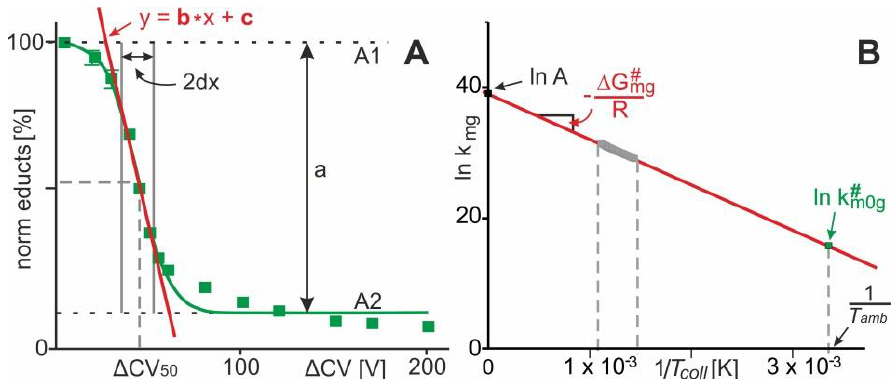
Figure 3. ( A ) Course of normalized ion intensities of complex ions ( 𝒏𝒐𝒓𝒎 (𝒆𝒅𝒖𝒄𝒕𝒔) ) as a function of collision cell voltage differences ( 𝚫𝐂𝐕 ). Each data point is the mean of several independent measurements. Vertical bars give standard deviations. The curve was fitted using a Boltzmann function. The tangent line equation is taken from the Boltzmann fit. “ a ” describes the difference between the lowest and highest data points on the sigmoidal fit. “ 2dx ” is the x-axis interval within which the steepest decline of educts is observed; the center of the 2dx interval is 𝚫𝐂𝐕 50 . ( B ) Arrhenius plot for the course of protein-ligand complex dissociation in the gas phase. The value for 𝐥𝐧𝐤 𝐦𝟎𝐠# is taken from the point of the line at 𝟏 . 𝐓 𝐚𝐦𝐛